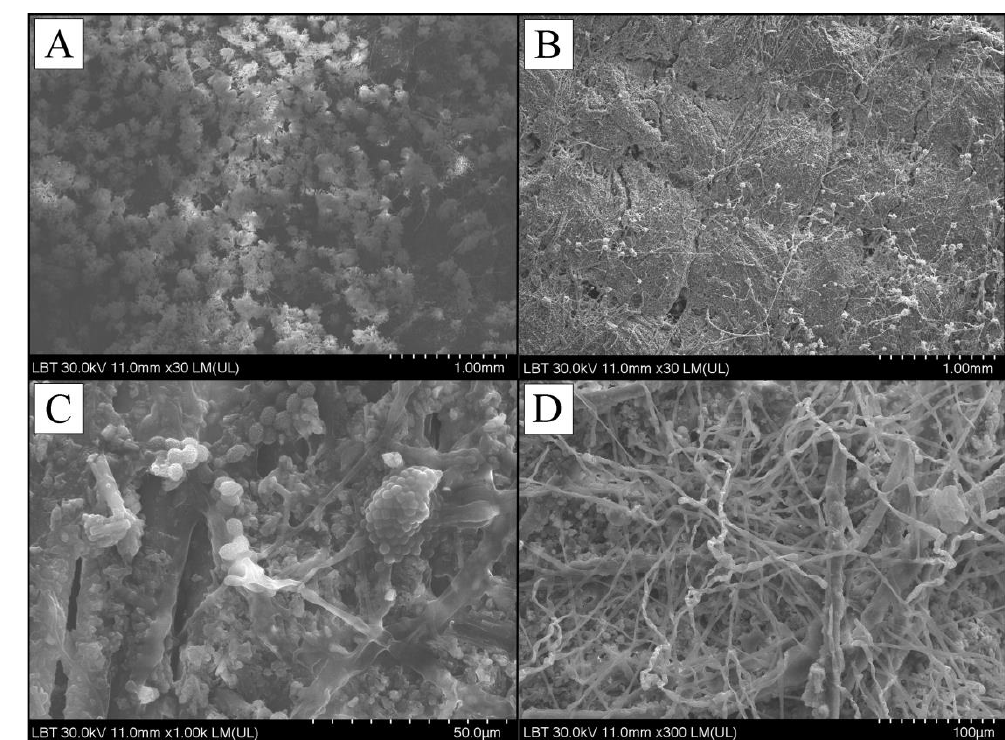
Figure 8. SEM analysis of sample number 2 of canvas from the walls of the wooden church. ( A ) — SEM image of the surface inoculated with fungi of Aspergillus tamarii species; ( B ) — SEM image of the surface inoculated with fungi of Aspergillus tamarii species after applying UVB treatment; ( C ) — SEM image of the surface inoculated with fungi of the species Cladosporium cladosporiodes ; ( D ) — SEM image of the surface inoculated with fungi of the species Cladosporium cladosporiodes after application of UVB treatment.